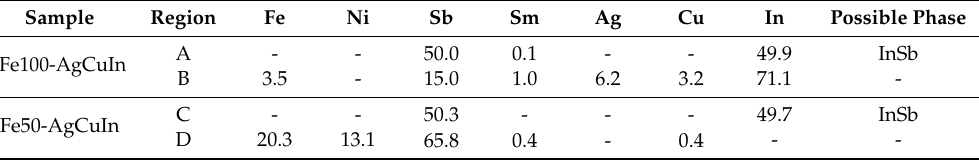
Table 2. EDS chemical analysis (at. %) of different regions identified in the wetting samples tested with AgCuIn and indicated in Figures 4 (regions A and B) and 5 (regions C and D); at least five spots were analyzed for each phase.